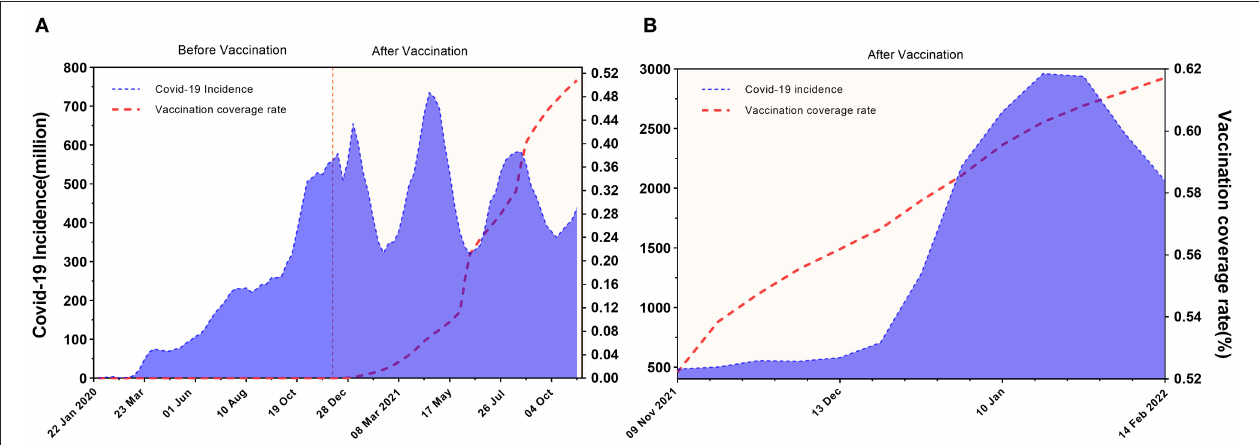
FIGURE 2 | Global trends of COVID-19 incidence gradually decline as vaccination coverage increases. The period for (A) is from 22 January 2020 (first SARS-CoV-2 case worldwide) to 8 November 2021 (before Omicron onset). (A) shows that the incidence gradually decreases after countries began vaccination at week 47 (7–13 December 2020). The third peak of incidence (week 84) is much lower than the previous two peaks. The range for (B) is from 9 November to 13 February 2022 (Omicron onset till today). (B) reveals even if the Omicron incidence was considerably larger than other mutant strains from 9 November to 13 February 2022, the global incidence began to decline on 30 January 2022 after a short